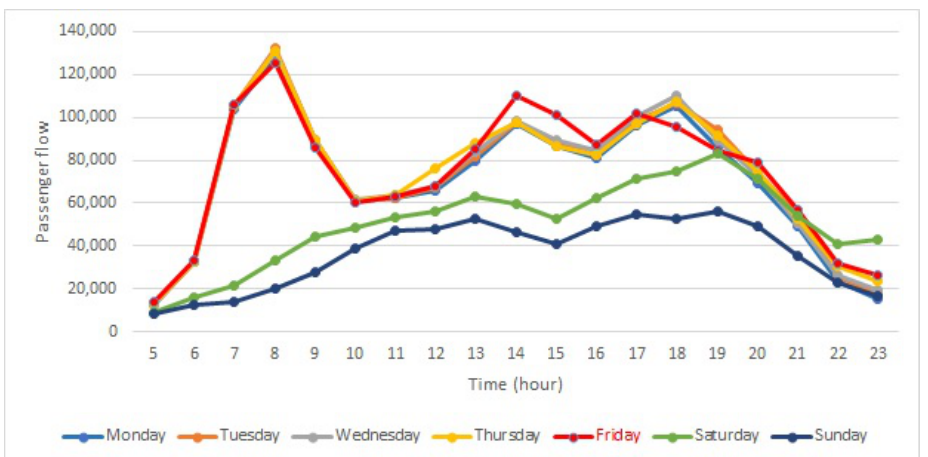
Figure 3. Time-varying diagram of passenger flow (total counts of boarding).